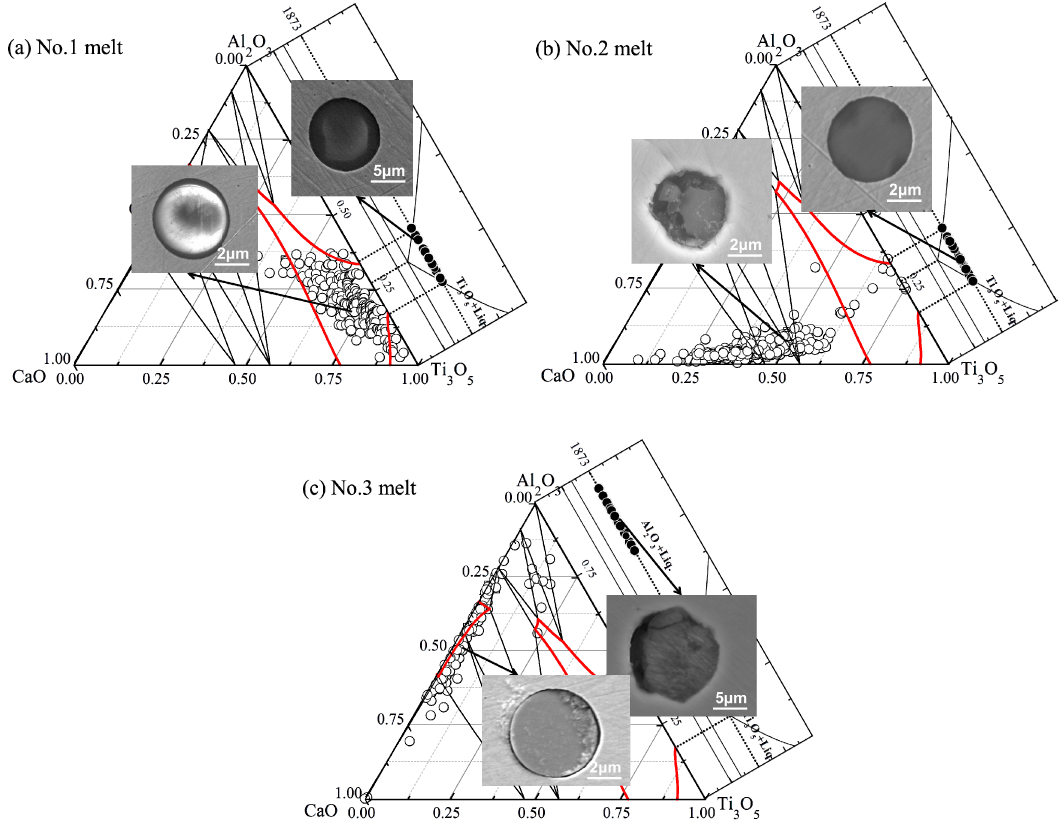
Figure 4. Morphologies and locations of inclusions in the isothermal sections. Thick red lines are the liquidus at 1873 K (1600 °C). The black plots represent the sample before calcium, and the white ones represent the sample after calcium. ( a ) No. 1 melt, ( b ) No. 2 melt, ( c ) No. 3 melt.